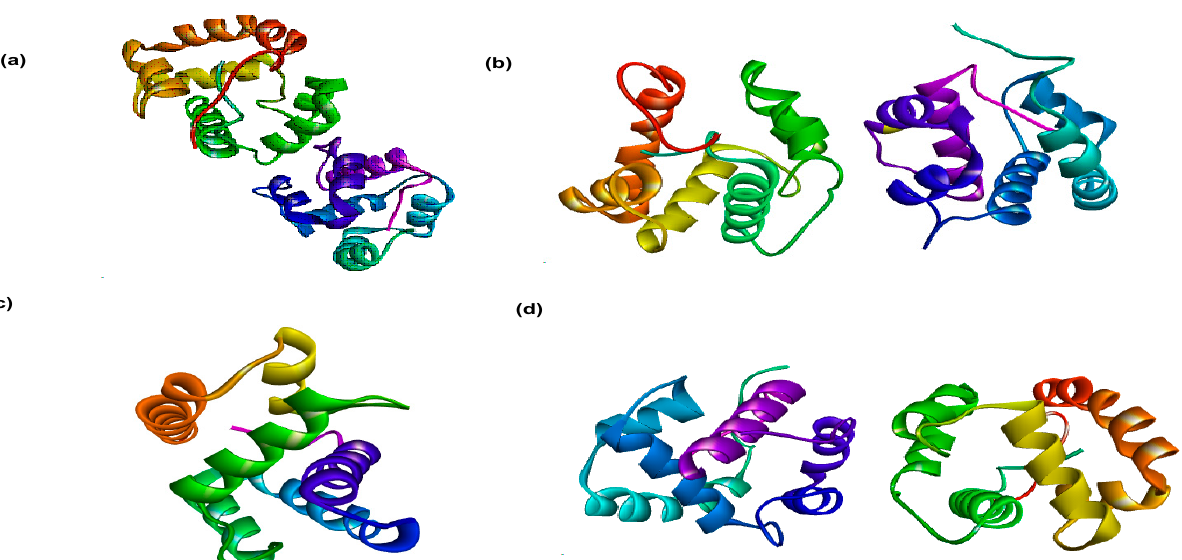
Figure 3. 3D structures of A. gambiae selected ( a ) OBP 1, ( b ) OBP 7, ( c ) OBP 4, and ( d ) OBP.